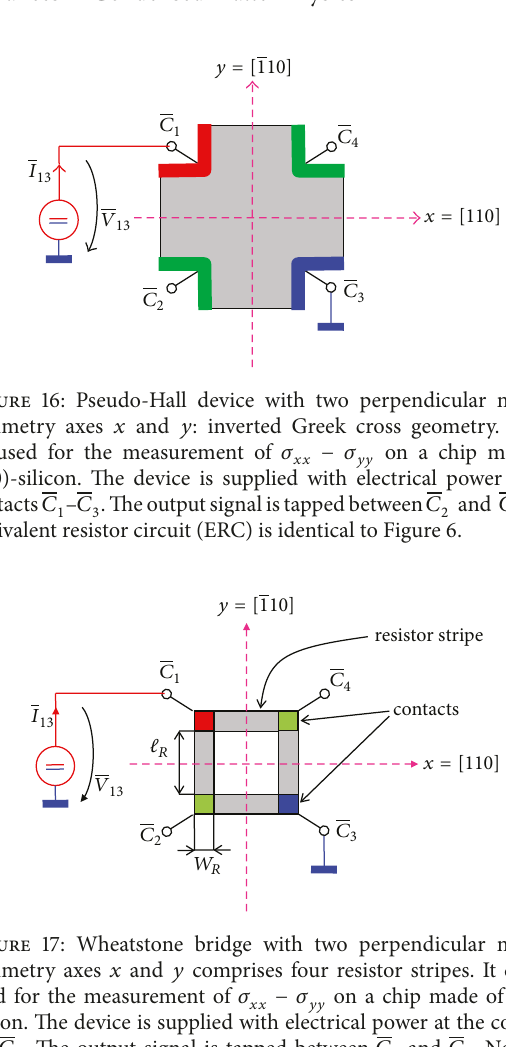
𝐶 𝐶 2 and 4 . Note the